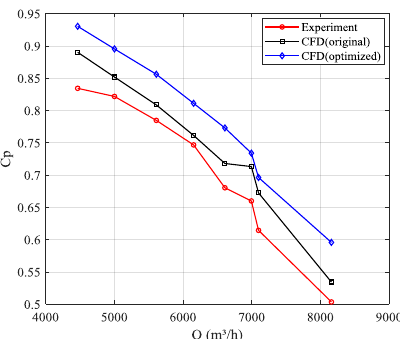
Processes 2020 , 8 , x FOR PEER REVIEW Figure 18. Pressure coefficient comparisons of Blade D500. Figure 18. Pressure coe ffi cient comparisons of Blade D500.